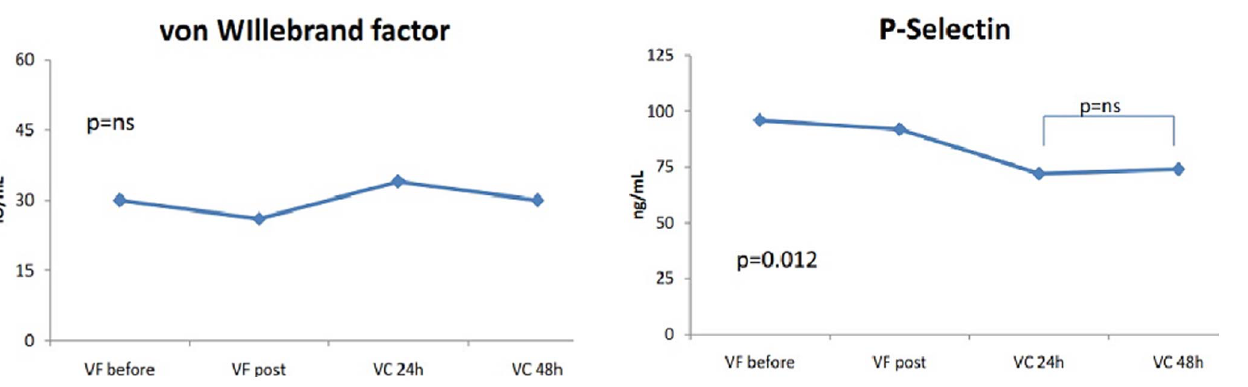
Figure 1. Changes in von Willebrand factor levels after catheter ablation.